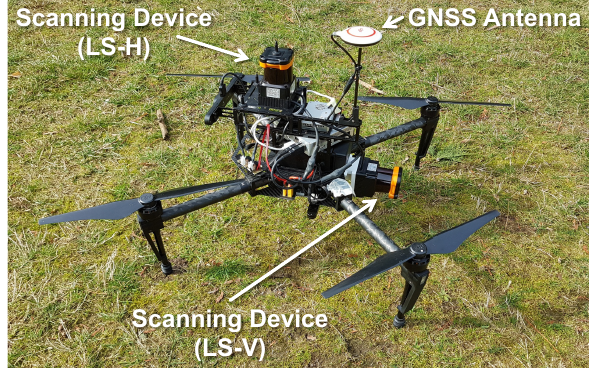
Figure 3. Overview on the proposed unmanned aerial system for UAV-borne laser scanning: the system involves a laser scanner scanning in the horizontal direction (LS-H) and a laser scanner scanning in the vertical direction